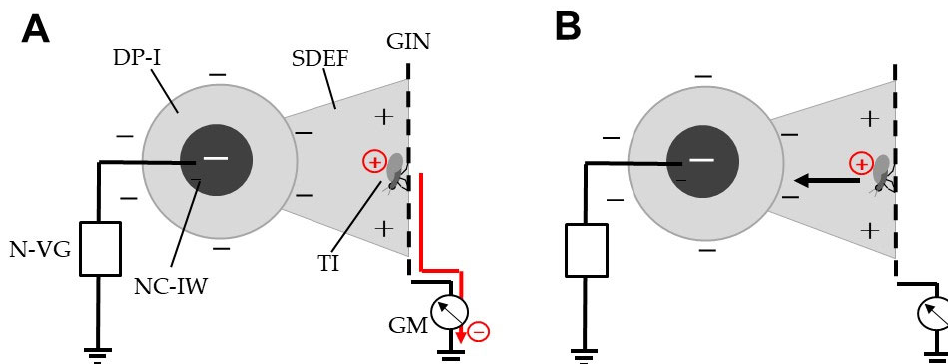
Figure 2. Schematic representation of insect capture showing discharge-mediated positive electrification of an insect in an SDEF. The SDEF was produced within the EF of an NC-IC. Free electrons were ejected out of the insect body, producing positive electrification ( A ), and the positively electrified insect was attracted to the NC-IC ( B ). Red arrow indicates the direction of free electron movement. Black arrow indicates the direction of the force attracting the positively electrified insect to the negatively charged insulated conductor. N-VG, negative voltage generator; DP-I, dielectrically polarized insulator with negative charge on its surface; NC-IW, negatively charged iron wire; GIN, grounded iron net; GM, galvanometer; TI, test insect